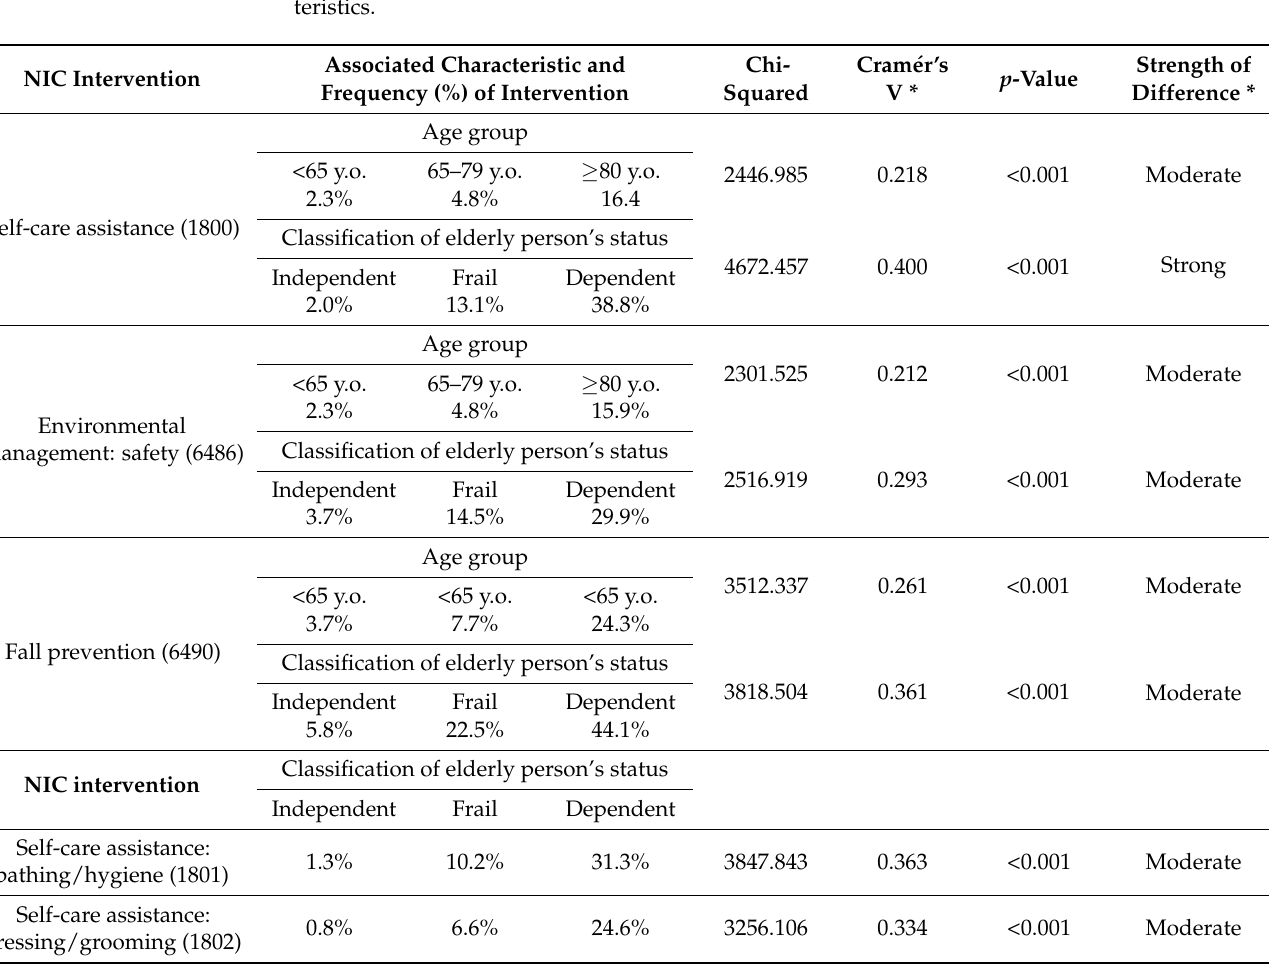
Table 7. Tests of association between the presence of recorded NIC interventions and patient charac-